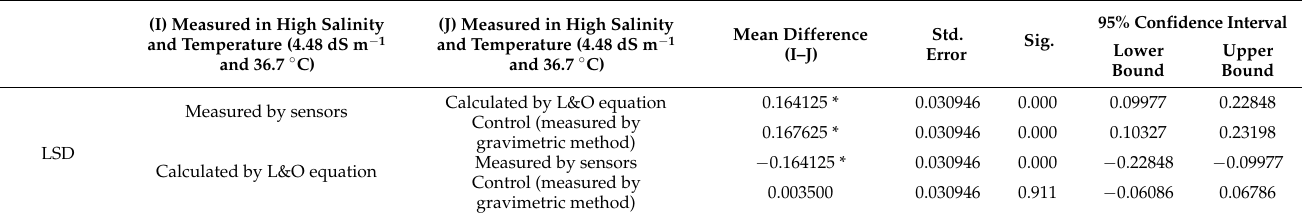
Table 10. Variance analysis of sensor readings of VWC as a function of salinity level and temperature, compared with actual VWC values by gravimetric method and calculated VWC by proposed L&O equation. Dependent variable: values of